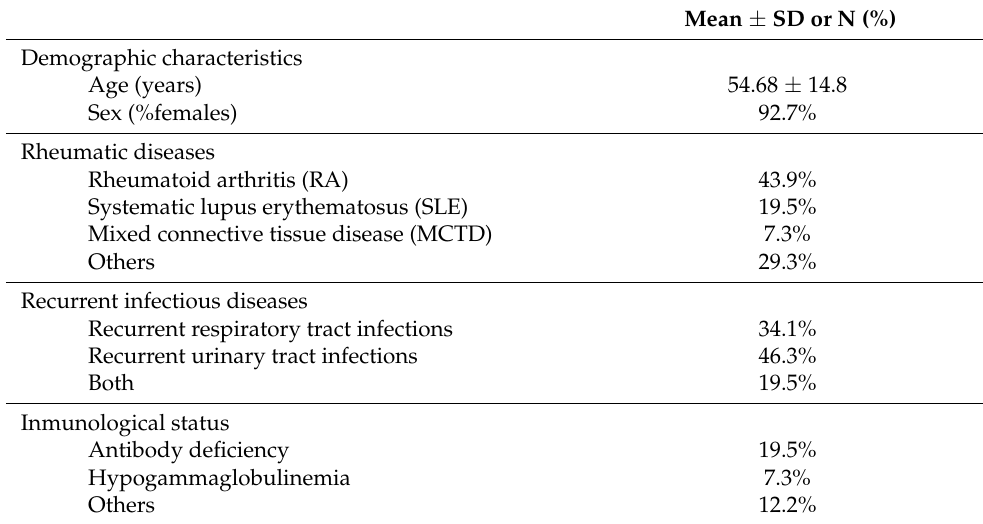
Table 1. Demographic and clinical characteristics of